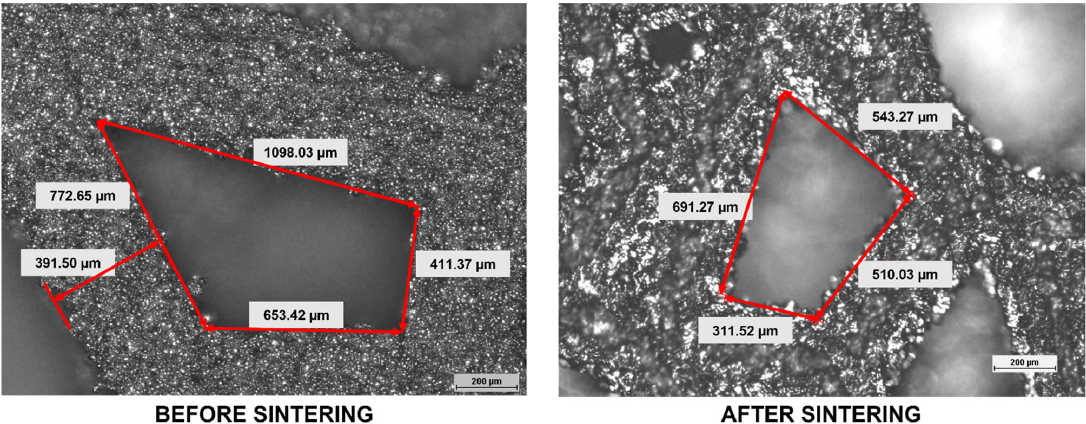
Figure 6. The dimensions of the struns of the Voronoi structure obtain from optical microscopy.